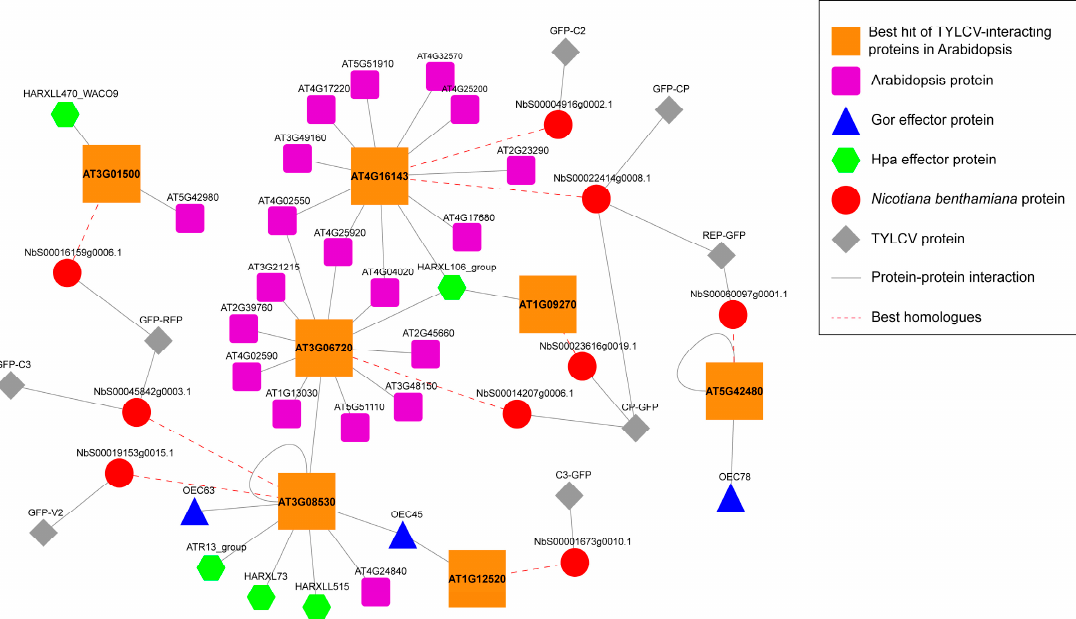
Figure 4. Network representation of the Arabidopsis best hits of the N. benthamiana interactors of TYLCV proteins convergently targeted by other pathogen effectors [15,17]. Gor: Golovinomyces orontii . Hpa: Hyaloperonospora arabidopsidis . N. benthamiana proteins interacting with viral proteins are depicted as red circles; TYLCV proteins are depicted as grey diamonds. Red dashed lines link N. benthamiana proteins and their best hit in Arabidopsis; Arabidopsis best hits of N. benthamiana proteins are depicted as big orange squares; other Arabidopsis proteins interacting with Arabidopsis best hits of N. benthamiana proteins are depicted as small purple squares. Effector proteins from G. orontii are depicted as blue triangles; effector proteins from H. arabidopsidis are depicted as green hexagons. Grey lines indicate protein-protein interactions.